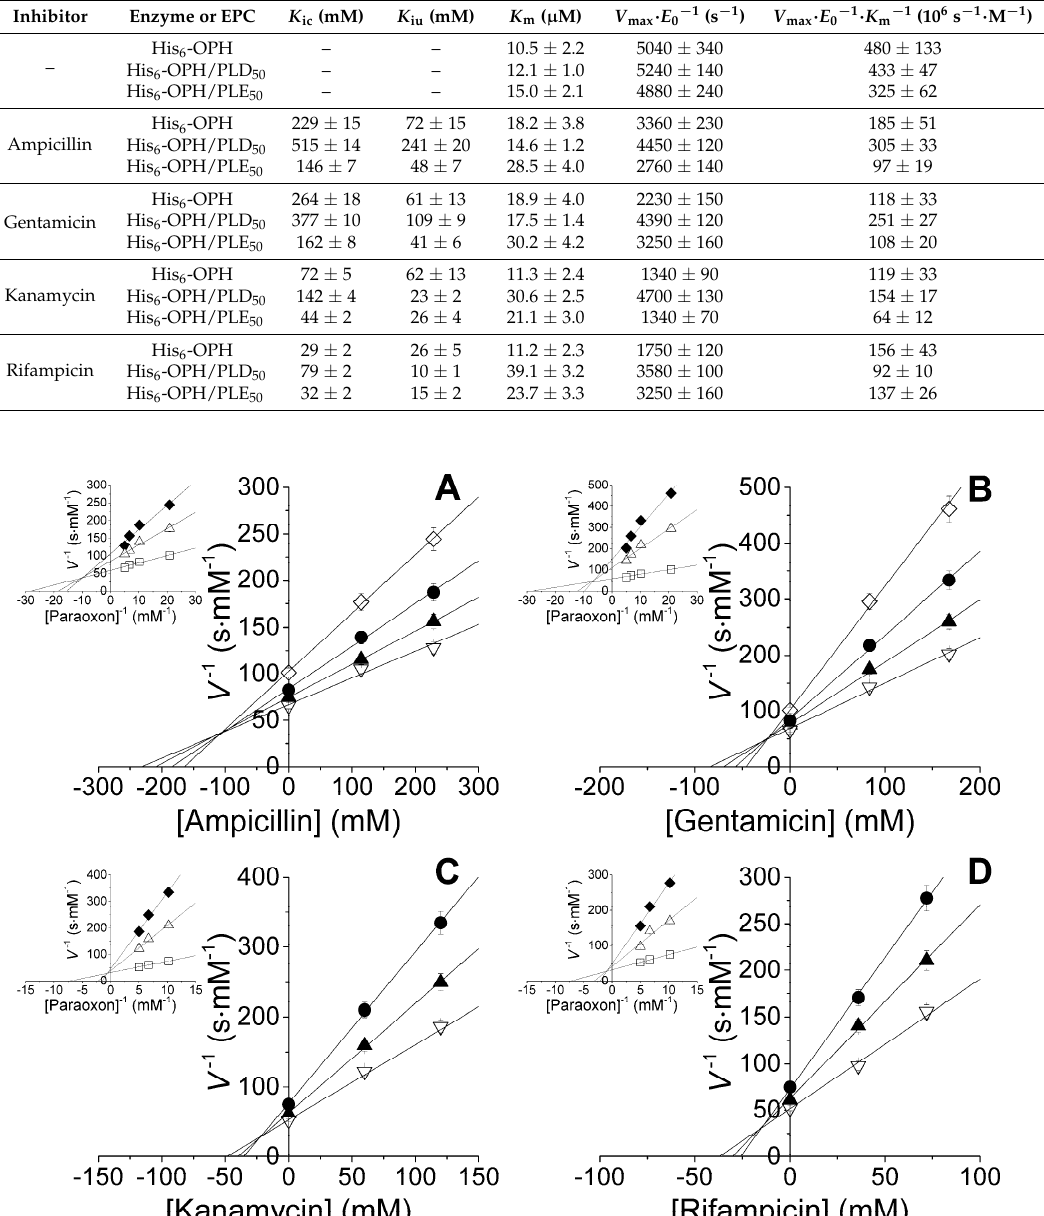
Table 1. Catalytic constants of hexahistidine-containing organophosphorus hydrolase (His 6 -OPH) and its polyelectrolyte complexes with poly- L -aspartic acid (His 6 -OPH/PLD 50 ) and poly- L -glutamic acid (His 6 -OPH/PLE 50 ) during Paraoxon hydrolysis in the presence of various antibiotics. K ic and K iu are competitive and uncompetitive inhibition constants, respectively. Apparent constants K mapp and V maxapp were calculated in the presence of antibiotics. EPC = enzyme-polyelectrolyte complexes.